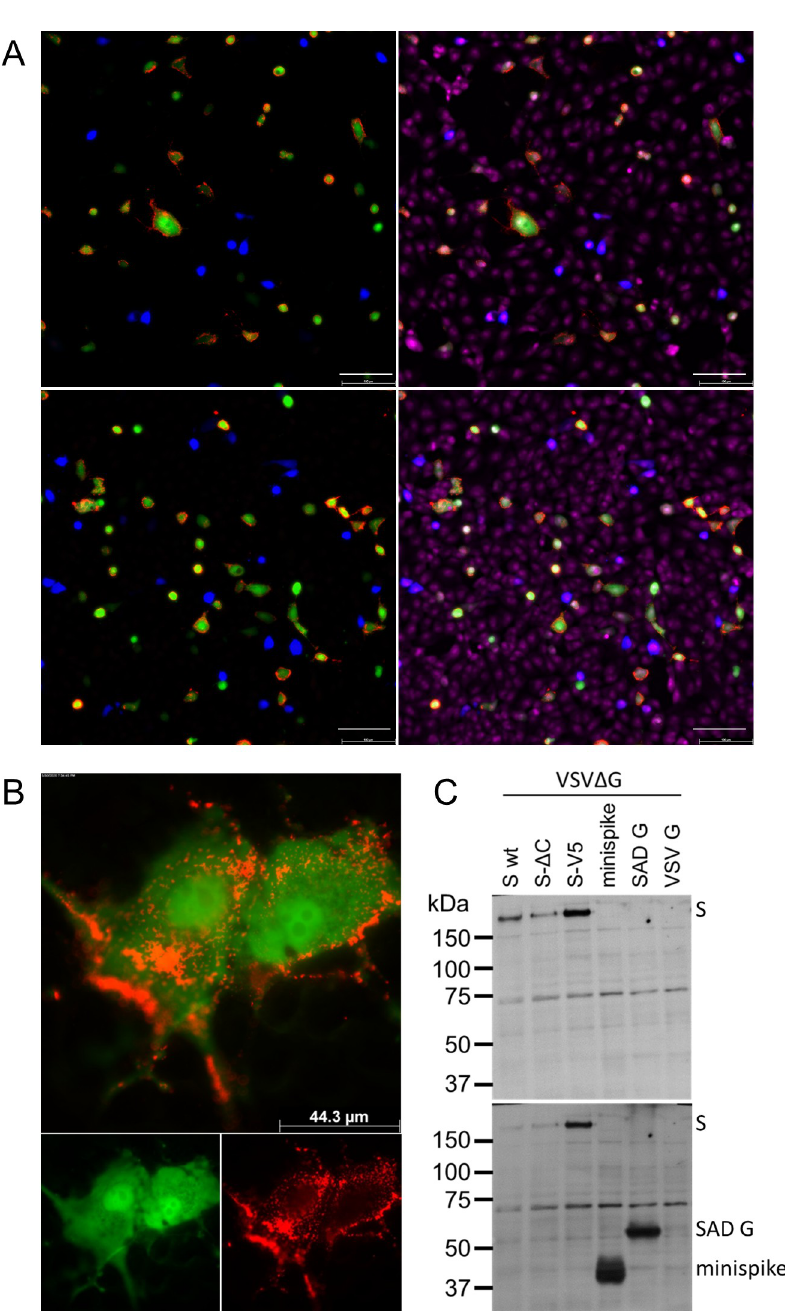
Fig 4. Virus minispike presents conformational RBD epitopes. (A) VeroE6 cells infected over night with VSV Δ G- minispike-eGFP (green) are recognized by IgG of S ELISA-positive patients in contrast to a control replicon expressing blue fluorescent protein (VSV Δ G-BFP). Live cells were incubated with patient serum (pat. ID 84; for other sera see S1 Fig) (upper panel) or SARS-Cov S Mab CR3022 visualized with anti-human IgG Alexa 555 (red). After permeabilization, nuclei were visualized with ToPro3-iodide. 200x magnification. Size bar represents 100 μ m. (B) Cells infected with a RABV replicon expressing minispike (green) are recognized by IgG of S ELISA-positive patients (red). Live unpermeabilized VeroE6 cells were infected with SAD Δ G-minispike-mNeongreen, incubated over night at 37˚C, and stained as described for (A), but without permeabilization and nuclear staining. 1000 x magnification. (C) Poor recognition of denatured minispike protein by patient immune sera. VSV Δ G-eGFP virions pseudotyped with full length wt S, a C-terminally truncated S (S Δ C) or a V5-tagged S protein (S-V5) were processed for denaturing SDS Western blot and probed with a representative patient serum (Pat. #84). In contrast to the full length S proteins, denatured minispike was not readily recognized by human serum IgG. In the lower panel minispike expression was